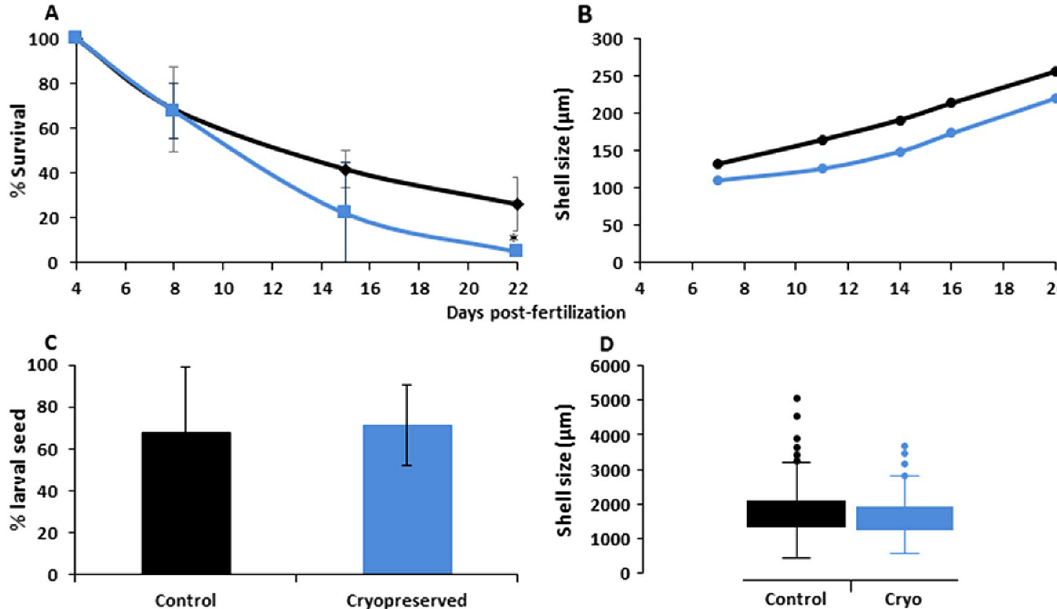
Figure 5. Fitness parameters (survival, larval shell size and settlement success) assessed over the long-term experiment carried out with F1 Mytilus galloprovincialis 72 h-old D-larvae. ( A ) Survival percentages of post- thawed larvae for 22 days, cultured in 150-L tanks (n = 4 tanks per treatment). Mean ± Standard Deviation (SD). ( B ) Shell growth of normal D-larvae throughout 22 days developed from cryopreserved (blue) or control (black) 72 h-old D-larvae (n = 35 per replicate). Mean ± Standard Deviation (SD). ( C ) Percentage of settled larvae developed from cryopreserved (blue) and control (black) larvae cultured in 50 cm 3 settlement drums (150-µm mesh) (10,000 larvae/drum, n = 8 drums per treatment). Percentage settlement expressed as the proportion of juveniles obtained from the sub-sample of competent larvae studied in each treatment. Mean ± Standard Deviation (SD). ( D ) Box plots for the distribution of shell sizes in microns (µm) of settled larvae. The line inside the box represents the median value and box ends correspond to upper and lower quartiles. Upper and lower whiskers represent values outside the middle 50% quantile. Asterisk shows significant differences. p-value of ANOVA-one way test, significance was considered at p <